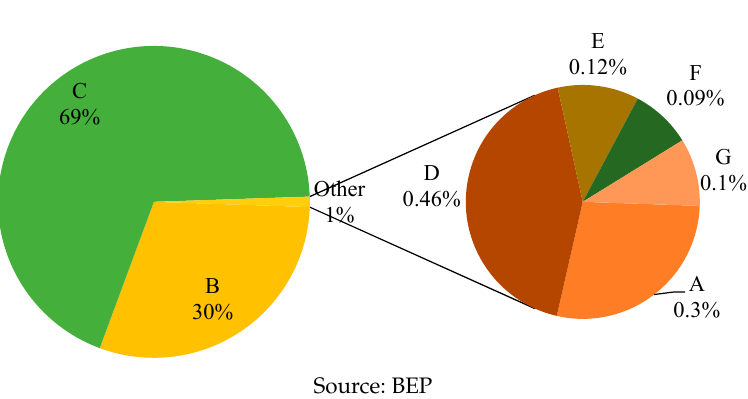
Figure 4. Distribution of New Building Energy Certificates by 2015 (after policy).